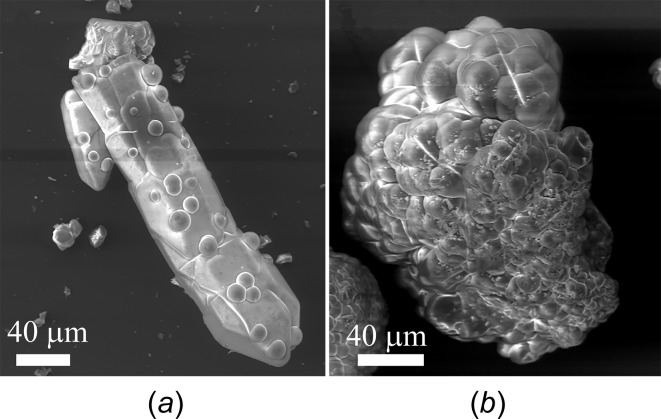
Electron microscope image showing (a) the crystalline and (b) the amorphous material in the initially synthesized heterogeneous green sample.